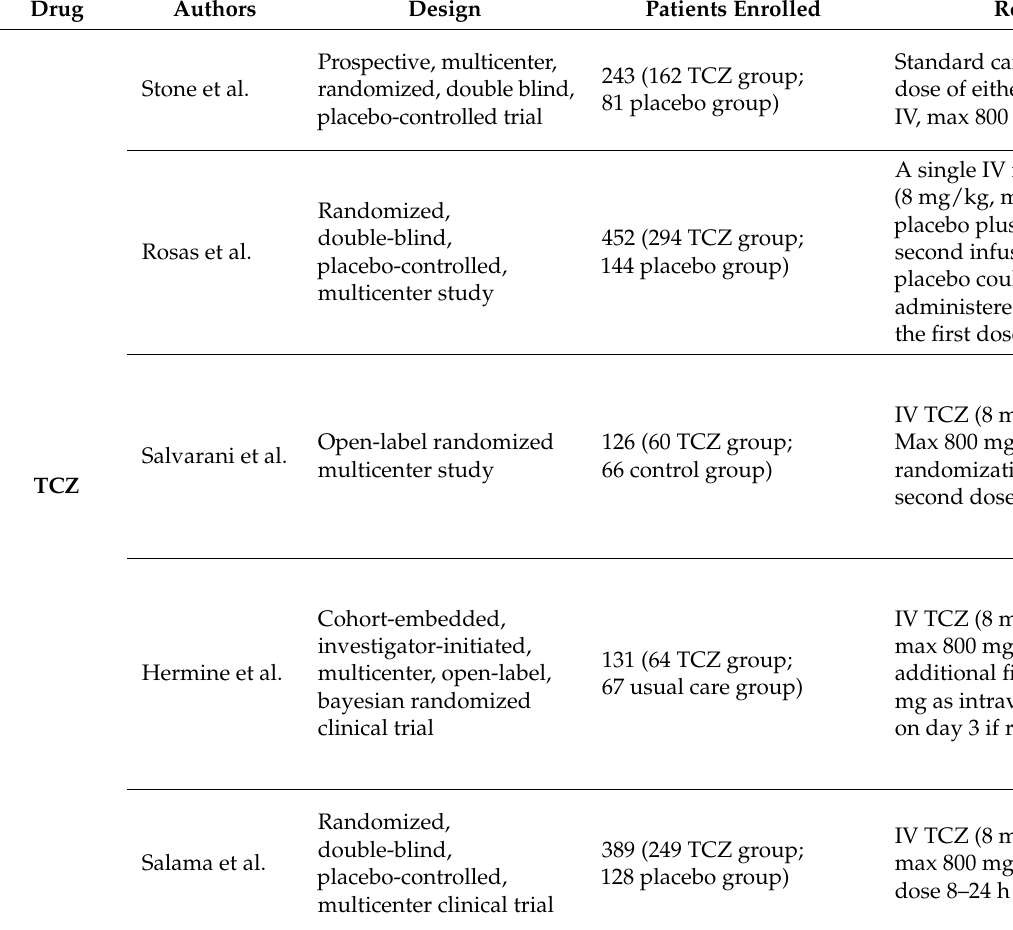
Table 1. Published randomized clinical trials evaluating the efficacy of anti-IL-6